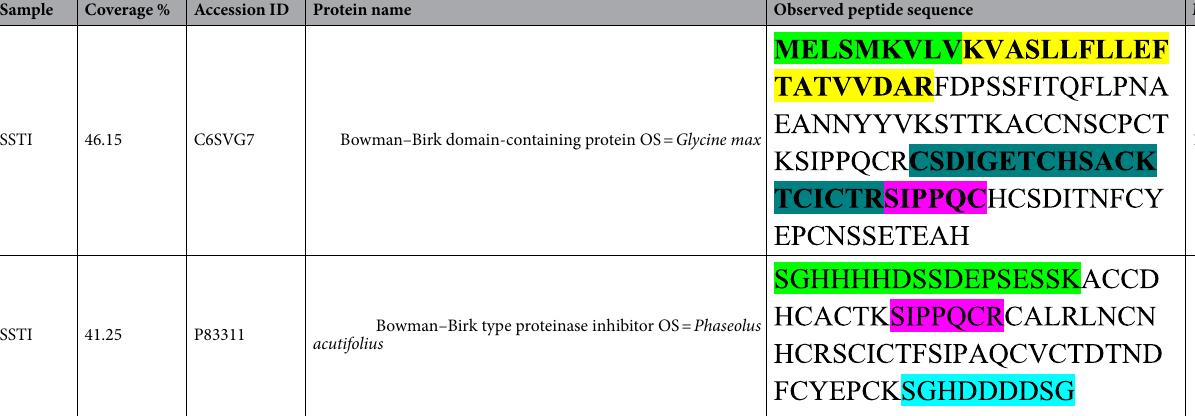
Table 2. Mass spectroscopic profiles of SSTI protein from Solanum surattence. Peptides that matched with specific region of earlier kwon Bowman-Birk type protease inhibitors are highlighted in different colors and bold.